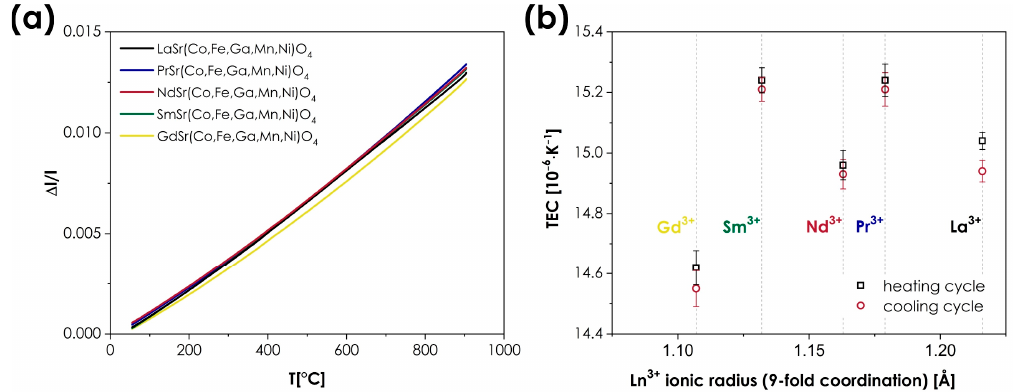
Figure 6. ( a ) Relative expansion of the LnSr(Co,Fe,Ga,Mn,Ni)O 4+ δ (Ln = La, Pr, Nd, Sm, or Gd) materials (based on the cooling runs); ( b ) the determined TEC values, presented as a function of the Ln 3+ ionic radii. Table 4. Thermal expansion coefficient values, determined by dilatometric studies for LnSr(Co,Fe,Ga,Mn,Ni)O 4+ δ (Ln = La, Pr, Nd, Sm, or Gd) series.